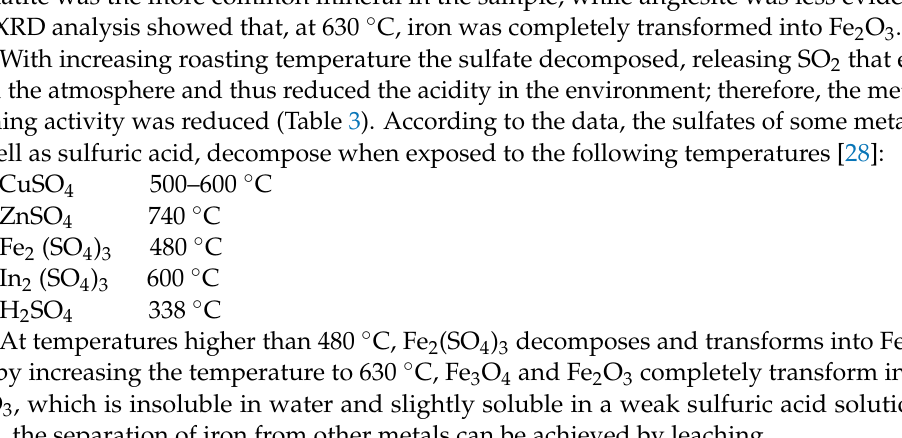
Fe 2 O 3 , which is insoluble in water and slightly soluble in a weak sulfuric acid solution. Here, the separation of iron from other metals can be achieved by